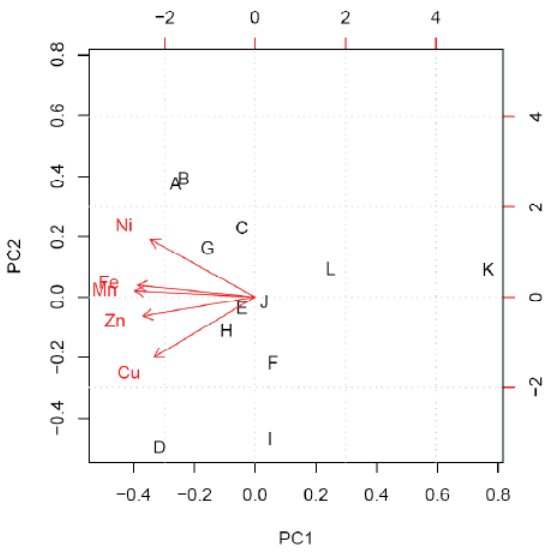
Figure 1. The principal component analysis (PCA) of the results. The two first PCs explain 88.7% of total variance.